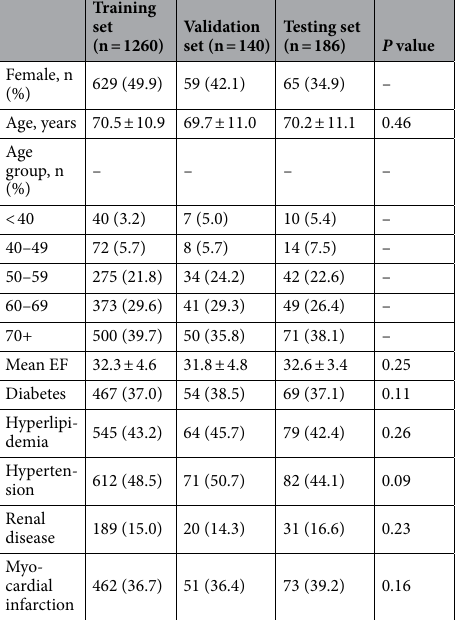
Table 2. Characteristics of the training, validation, and testing